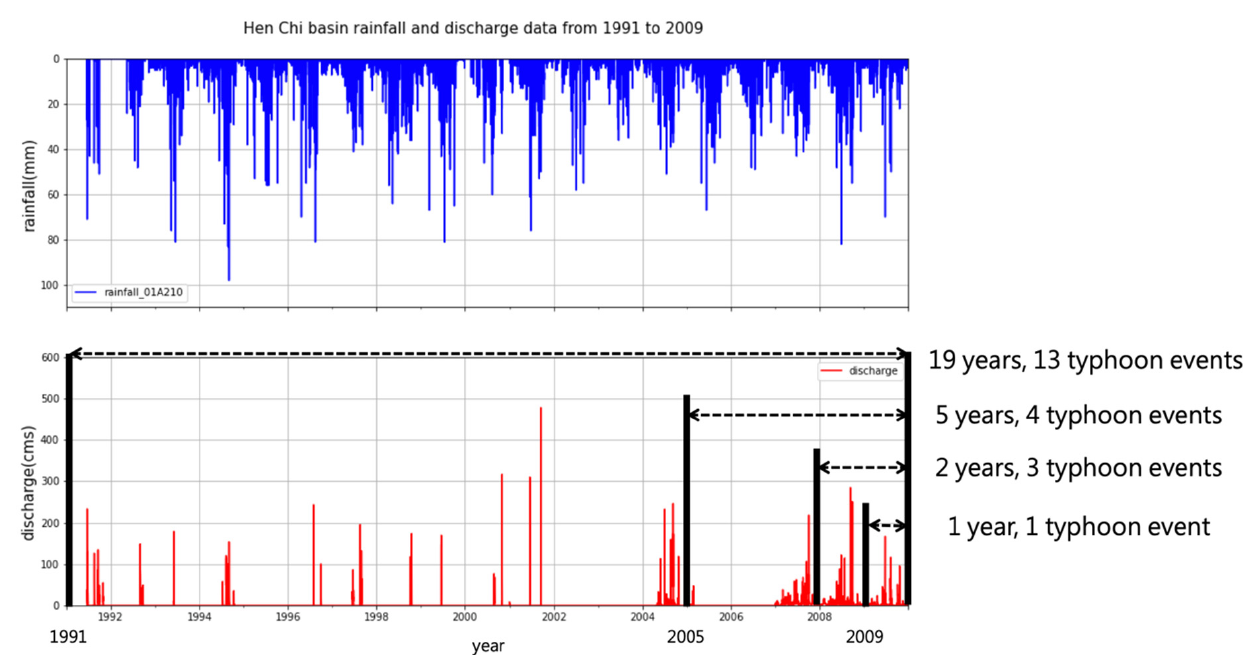
Figure 2. The time-series rainfall and discharge measurements from 1991 to 2009 for the Hen Chi watershed.